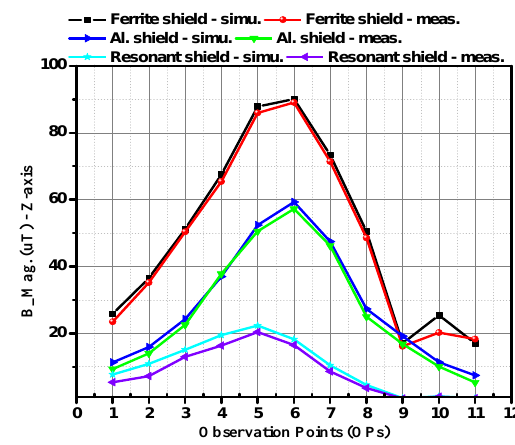
Figure 22. The experimental set-up.